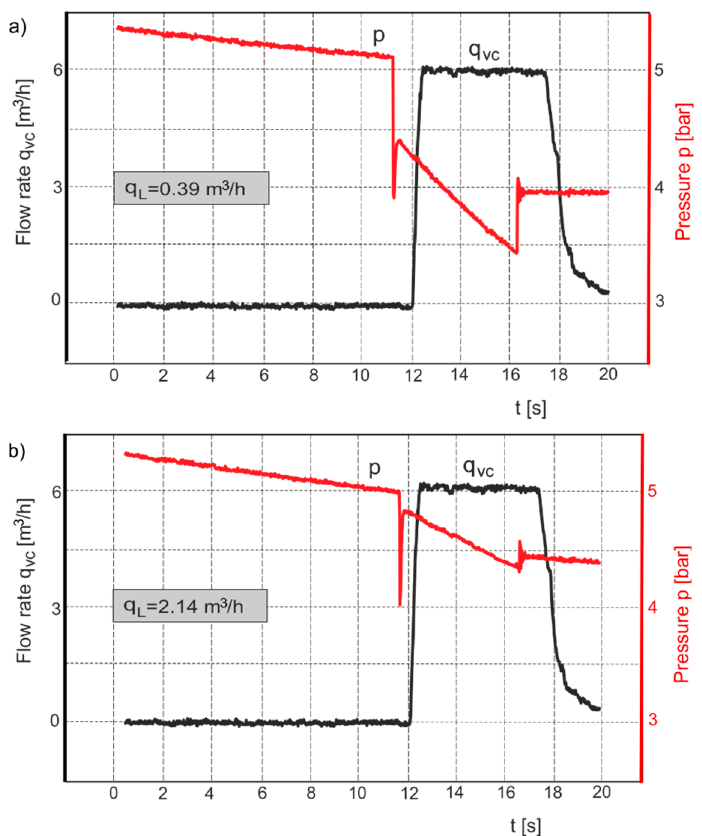
Figure 8. Graphical representation of measurement results for pressure p ( t ) and controlled flow rate q v c ( t ) for the selected diameter of the air nozzle, ( a ) d = 0.3 mm, ( b ) d = 0.7 mm. Table 1. The results of measurements and calculations from the charts in Figure 6.